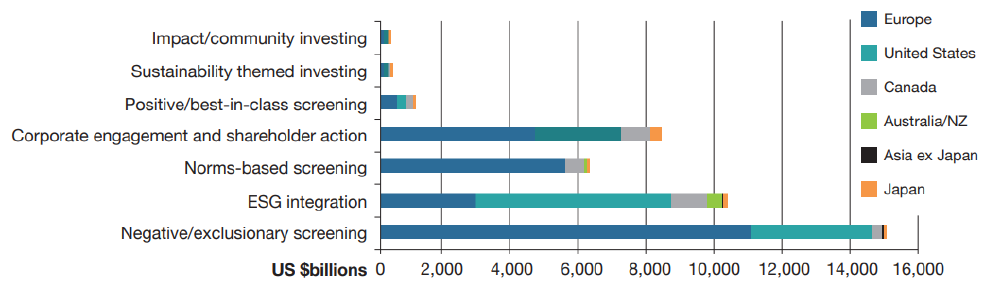
Figure A9. SRI assets by strategy and region 2016.